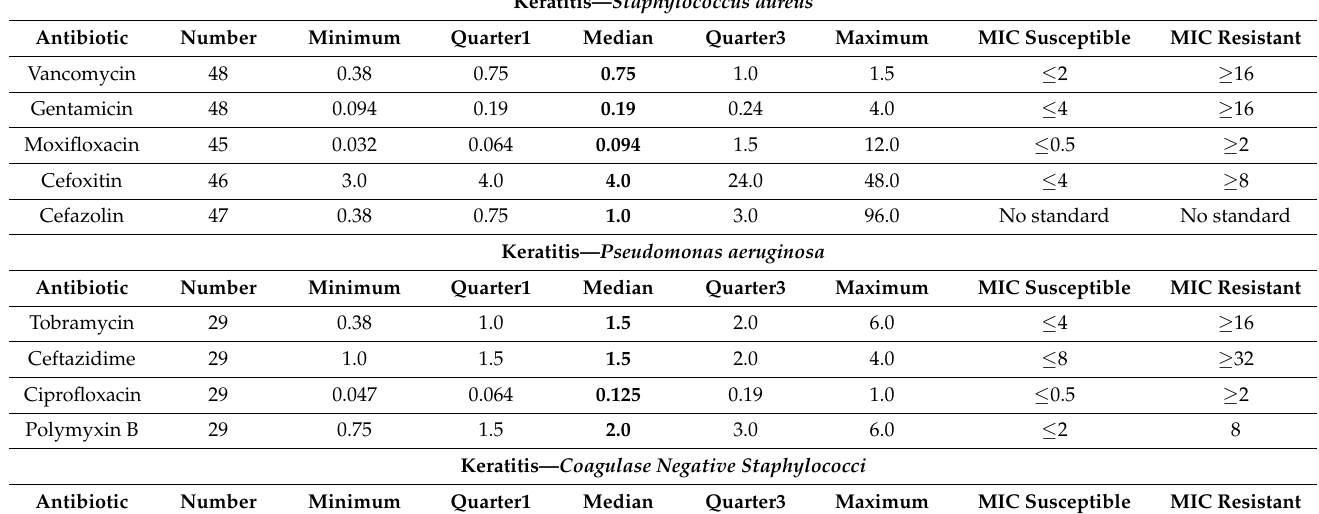
Table 1. MICs ( µ g/mL) of bacteria isolated from eye infections to common anti-infectives (January 2020 to September 2021). List contains the serum standards that may guide the treatment of ocular infections. (http://eyemicrobiology.upmc.com, accessed on 20 November 2021). Median MICs were